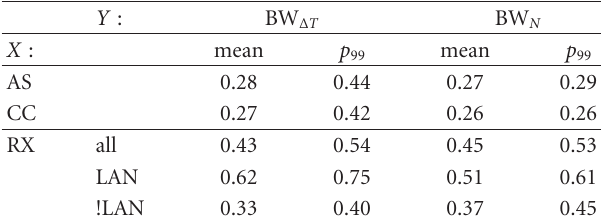
Table 2: Correlation ρ ( X , Y ) between bandwidth (BW), received bytes (RX) and peer localization information (CC, AS) for di ff erent groups of contributor peers (LAN, Internet,